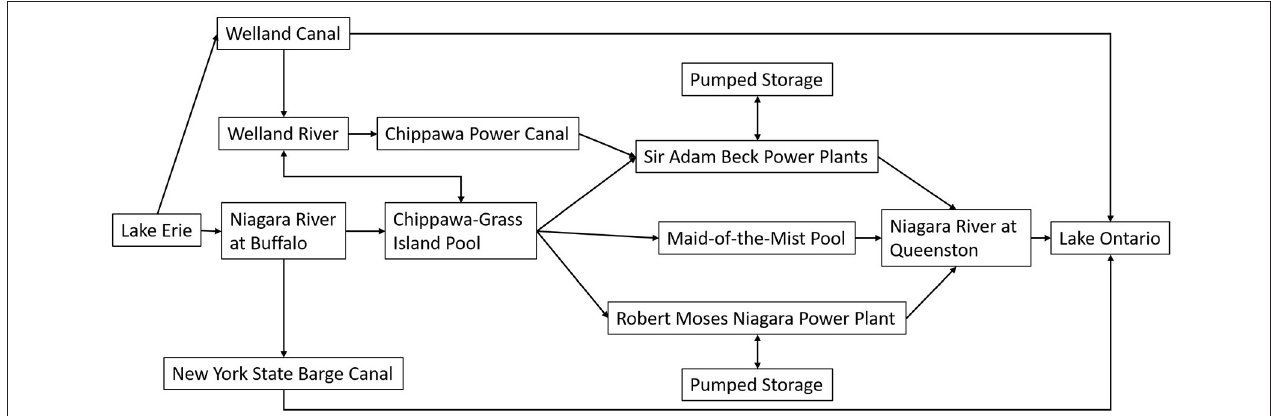
FIGURE 7 | Diagram of how water flows from Lake Erie to Lake Ontario. Note that the size of the arrows does not reflect the relative size of the flows. For example, the arrow pointing from the Welland Canal to the Welland River represents a siphon system discharging only about 6 m 3 /s, compared to flows of around 8,000 m 3 /s for the Niagara River at Buffalo [adapted from: Coordinating Committee on Great Lakes Basic Hydraulic Hydrologic Data